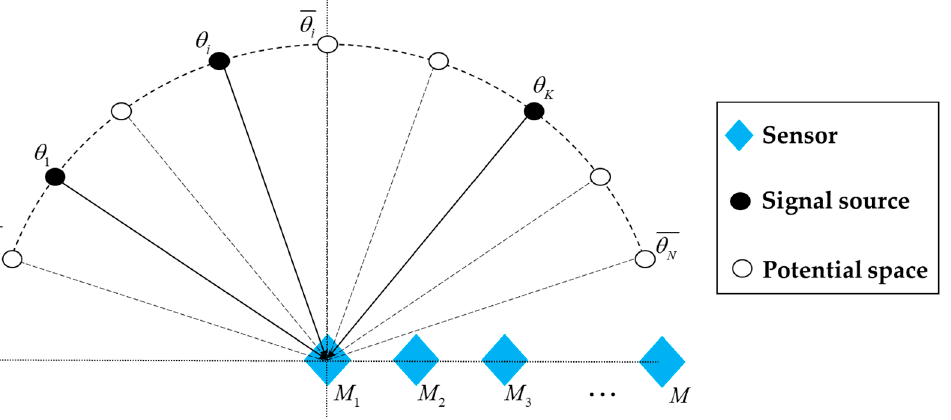
Figure 1. Sparse representation of array signals.